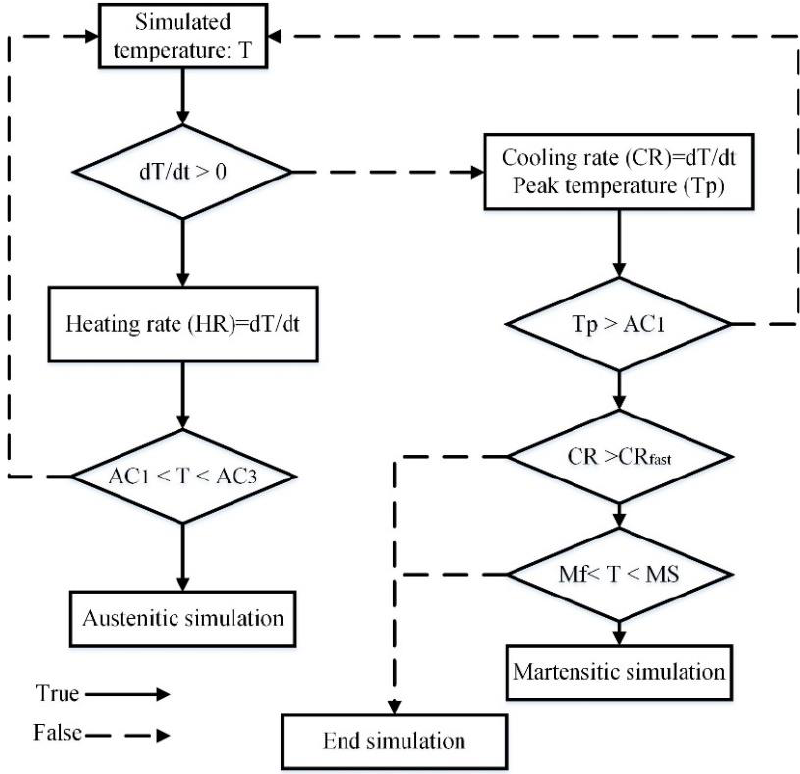
Figure 3. Simulation process.